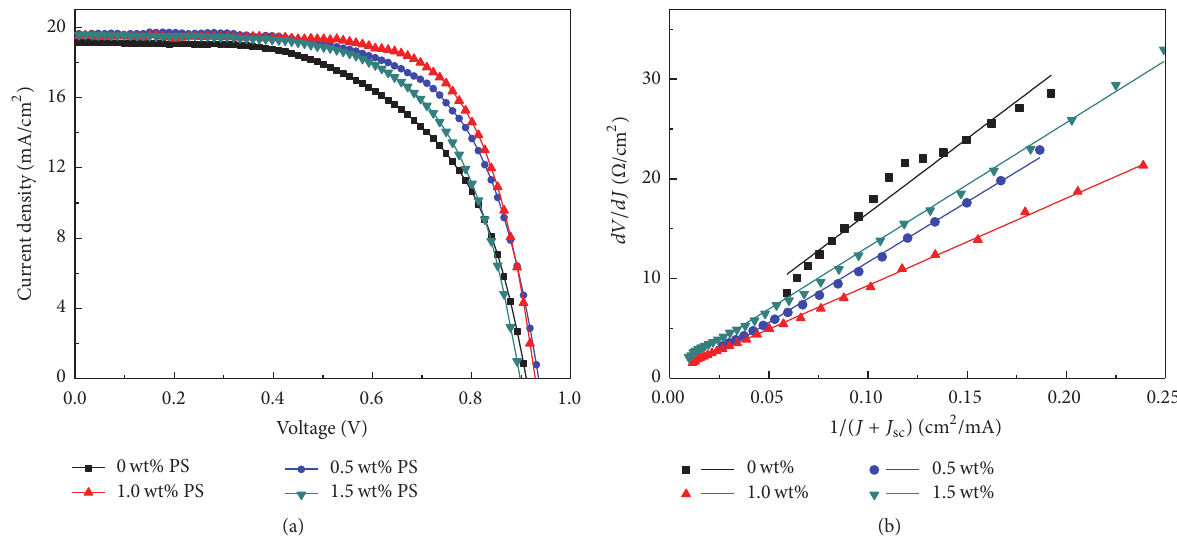
Figure 6: (a) Current density-voltage curves and the best-performing solar cells based on mp-TiO 2 film with different wt% of PS. (b) Plots of dV/dJ versus 1/( 𝐽 + 𝐽 sc ) and the linear fitting curves. Table 1: Photovoltaic performance of CH 3 NH 3 PbI 3 based devices as a function of different wt% of PS. wt% of